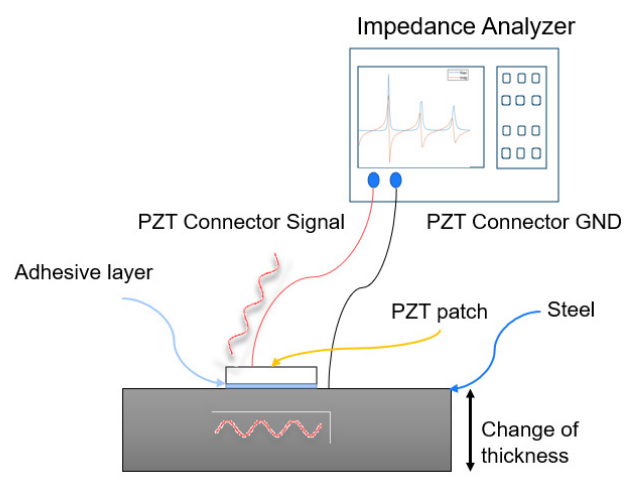
Figure 1. Electromechanical impedance principle.